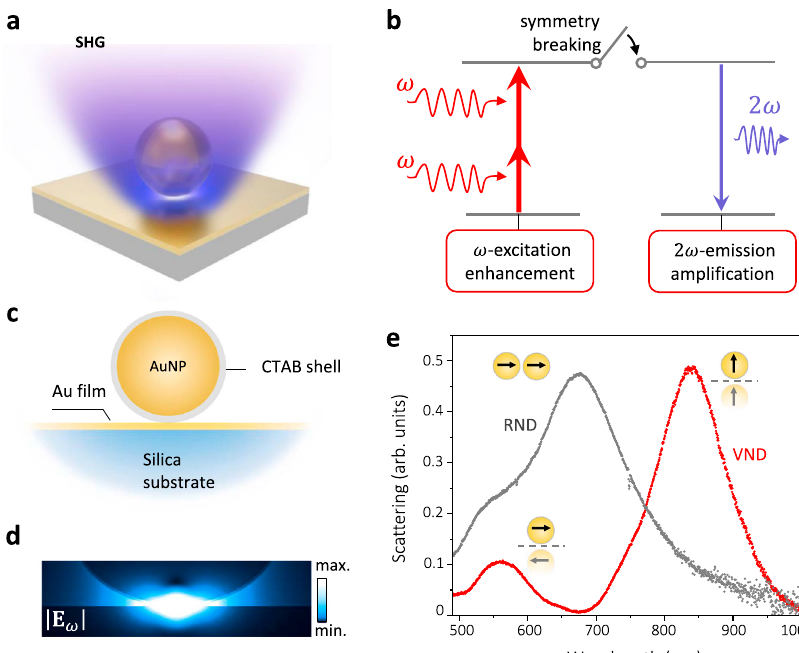
Fig. 1 Plasmonic response of a single metal particle-on- fi lm nanocavity and SHG enhancement mechanism. a Schematic of a gold particle-on- fi lm nanocavity construct. b Illustration of the SHG enhancement mechanism in plasmonic nanostructures: breaking structural symmetry allows SH coupling to a bright mode of the nanostructure and acts as a switch for SH emission. c Schematic of a CTAB-coated gold nanoparticle (AuNP) coupled to a gold thin fi lm on a silica substrate, equivalent to an extremely asymmetric virtual nanoparticle dimer (VND) in analogy to a symmetric real nanoparticle dimer (RND) made of two identical gold nanospheres as indicated in the inserts in ( e ). An AuNP diameter is ~100 nm and a CTAB shell thickness is ~1 nm. d Calculated near- fi eld intensity distribution in the nano-construct in ( c ) at a plasmonic resonance wavelength of 850nm for the electric fi eld perpendicular to the fi lm. e Dark- fi eld scattering spectra of a gold VND (red) and an RND (gray) both with the same geometric parameters as in ( c ). Insets schematically illustrate the coupled dipole modes in the VND and RND structures corresponding to their respective resonance peaks.